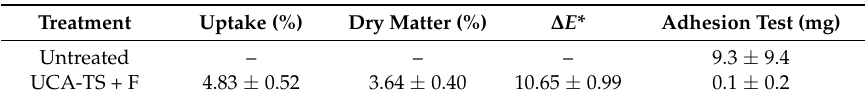
Table 3. Uptake, dry matter and total color difference ( ∆ E *) with respect to the untreated stone. Weight of the tape in the adhesion test is also